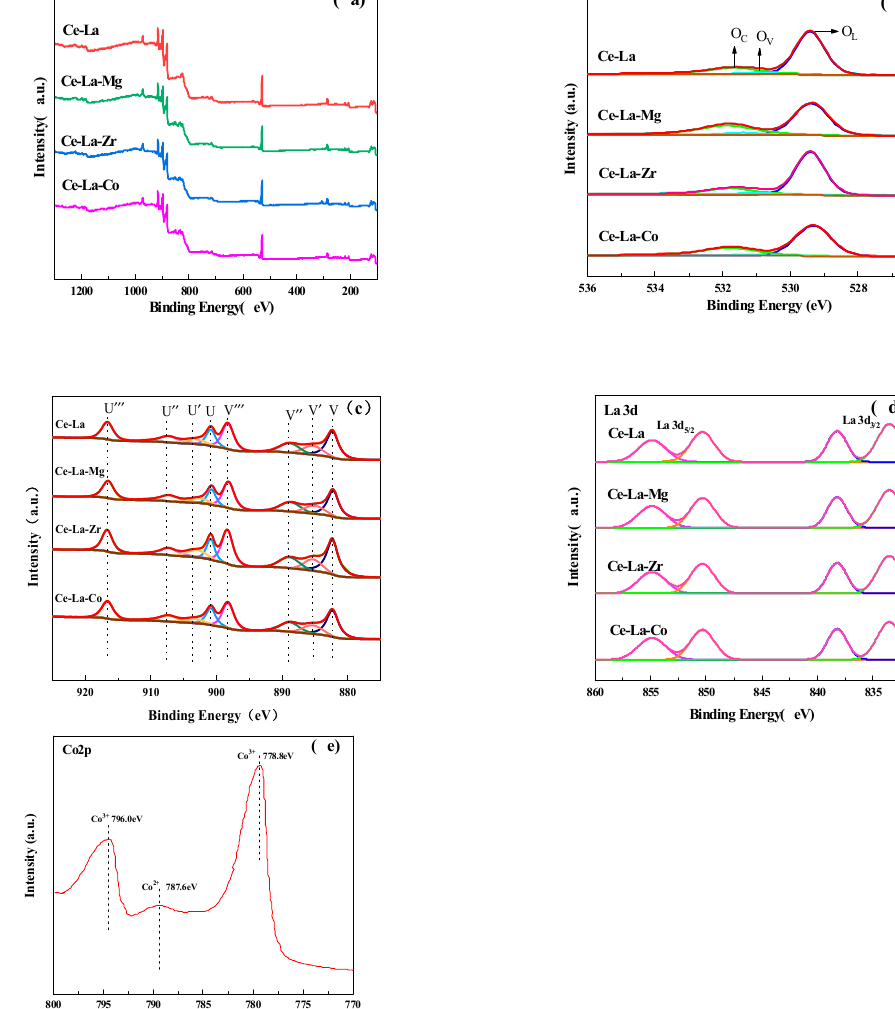
Figure 5. XPS spectra of Ce-La-M solid solution ( a ), O 1s ( b ), Ce 3d ( c ) La 3d ( d ), and Co 2p ( e ).